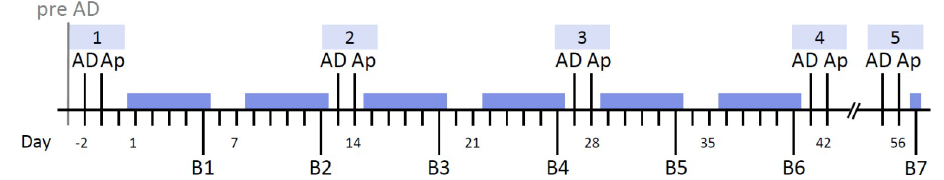
Fig 1. Experimental design. pre AD, pre-experimental avoidance distance test; AD, avoidance distance test; Ap, approach test; B1–7, behavioural observations. Treatment days are marked with a blue bar. Test numbers are given above AD and Ap indications, highlighted in light blue. For B7, the animals were treated as during the treatment period.